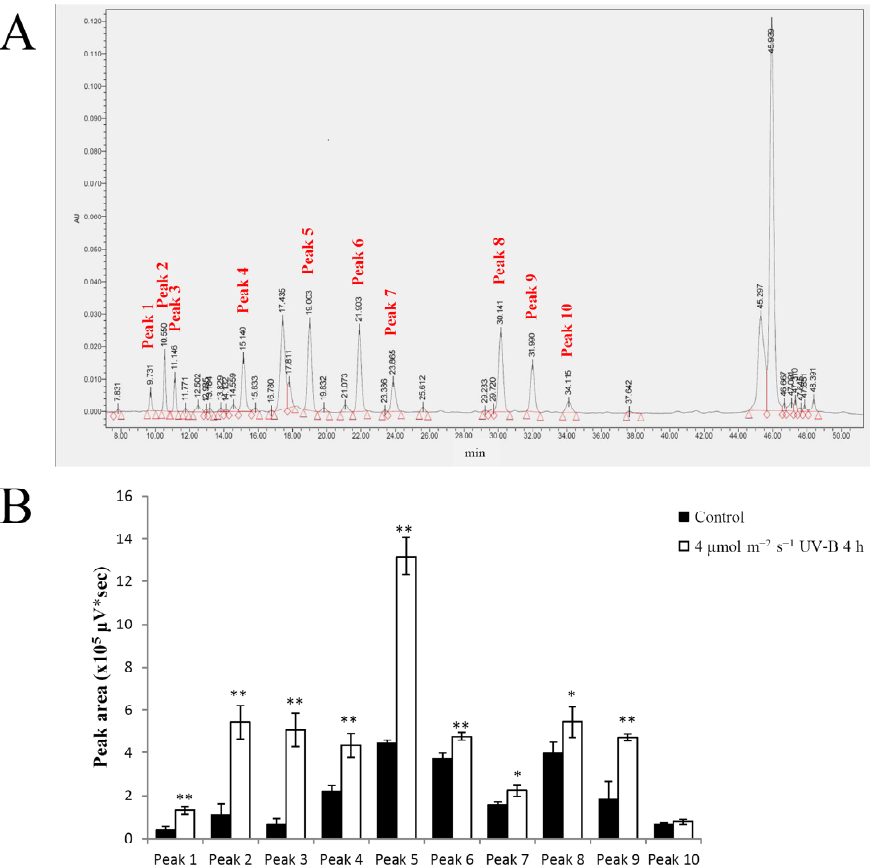
Figure 5. Determination of flavonoid concentrations in pakchoi in response to UV-B. ( A ) High performance liquid chromatography (HPLC) chromatogram of the flavonoids in extracts of 25-day-old seedlings. ( B ) The peak areas fractionated by HPLC. Twenty-five-day-old seedlings treated with 4 µmol·m − 2 ·s − 1 UV-B for 4 h were harvested for extraction. Twenty-five-day-old seed- lings not treated with UV-B radiation served as the control. Three independent biological replicate experiments were performed; data points represent the mean ± SE of the three biological replicates. Asterisks indicate a significant difference (* p < 0.05; ** p < 0.01) relative to the corresponding con- trol, using Student’s t -test. On the other hand, there was no obvious enhancement effect of UV-B radiation on glutathione and ascorbate concentrations in pakchoi (Figure S2). Pakchoi synthesizes comparatively high amounts of glucosinolates, most of which were not affected by re- duced UV-B conditions during the late developmental stages of pakchoi [7]. Flavonoids were still not evaluated and further investigations on glucosinolates are required. Nonetheless, these results revealed that the increase in non-enzymatic antioxidant activ- ity was mainly due to the accumulation of phenolic compounds, especially flavonoids. This finding is in agreement with previous studies that showed that UV-B radiation can induce the biosynthesis of flavonoids in a range of plants [29–32]. 2.4. Effects of UV-B Radiation on Flavonoid Biosynthesis Enzymes The phenolic and flavonoid compound biosynthesis pathway is one of the most ex- tensively studied areas of SPM. Flavonoids are synthesized via the shiki-